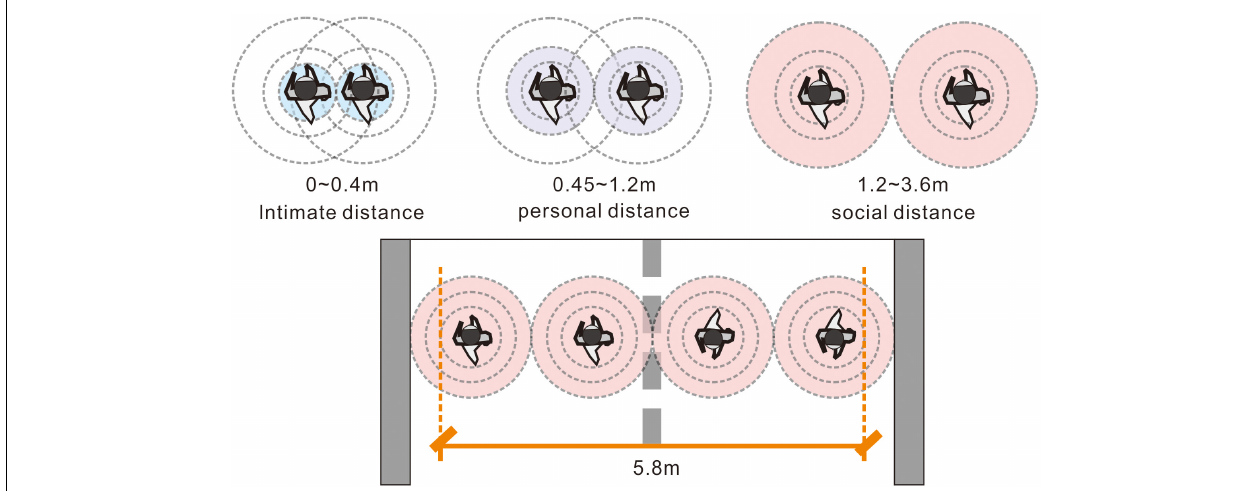
FIGURE 2 | Relatively comfortable width of a two-way path (cf., Hall, 1966).